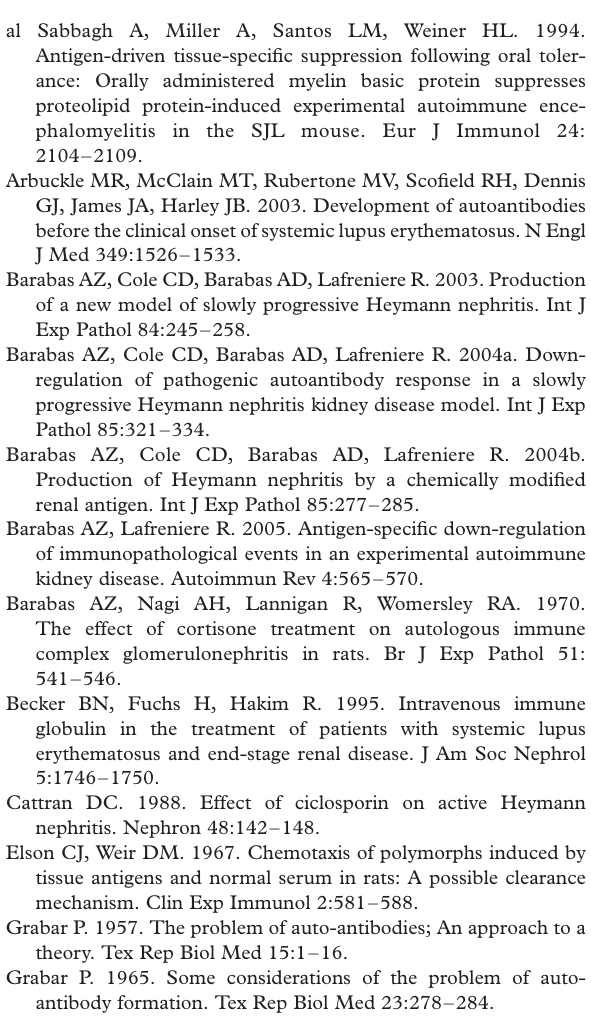
Table I. Incidence of SPHN and grade of glomerular IgG antibody deposition in SPHN treated and untreated rats and in control rats at the end of the experiment at 26 weeks. Groups of rats Number of and treatments rats in